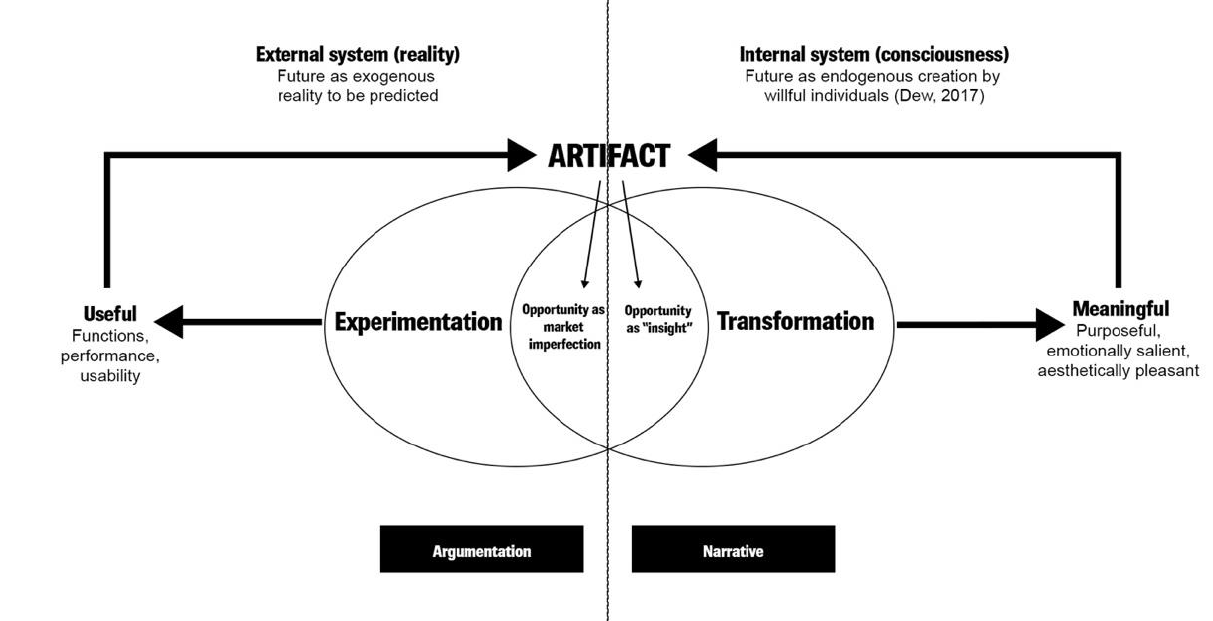
Fig. 1 . Entrepreneurial design as a duality between transformation and